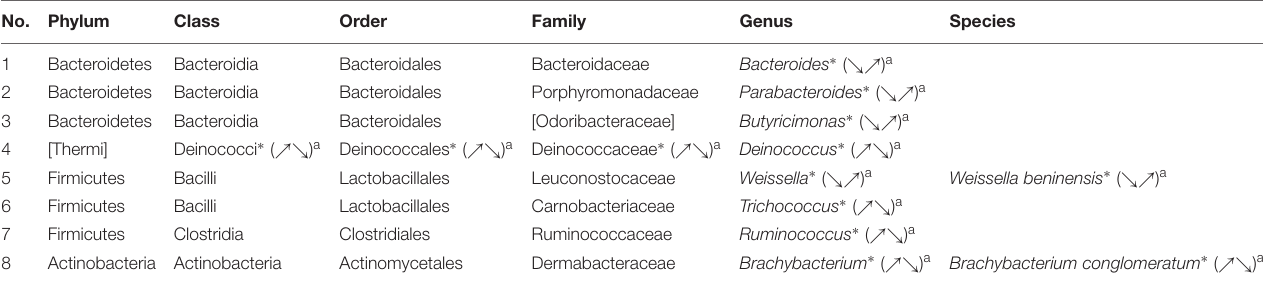
TABLE 2 | Significantly altered gut microbial taxa at different taxonomic levels in chronic unpredictable stress rats treated with C. tubulosa extract. No.